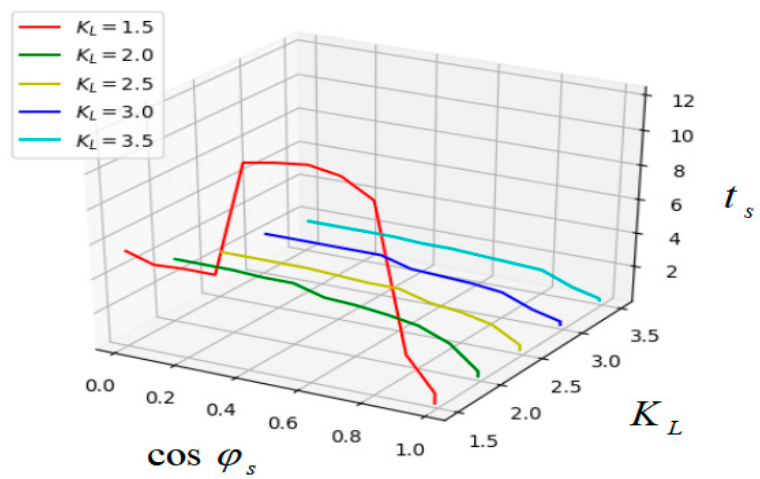
Figure 9. The relationship between cos ϕ s , K L and t s with the sampling method of di s / dt